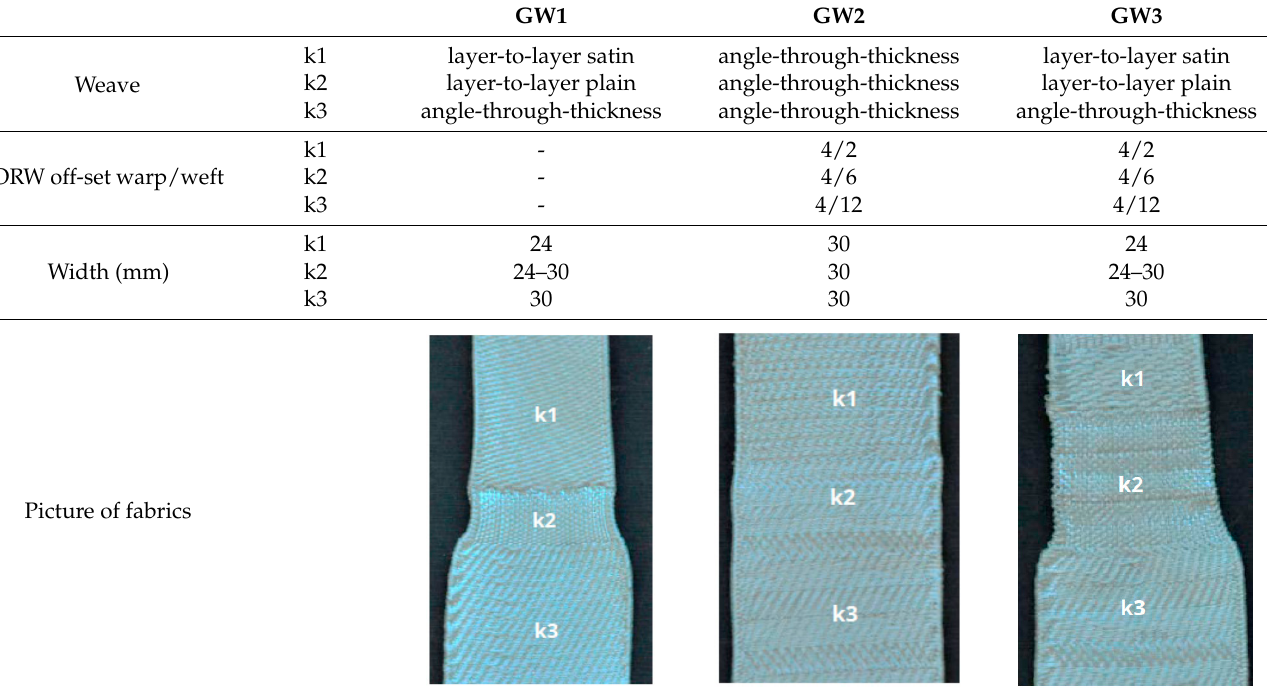
Table 3. Developed woven structures with geometrical and/or structure mechanical